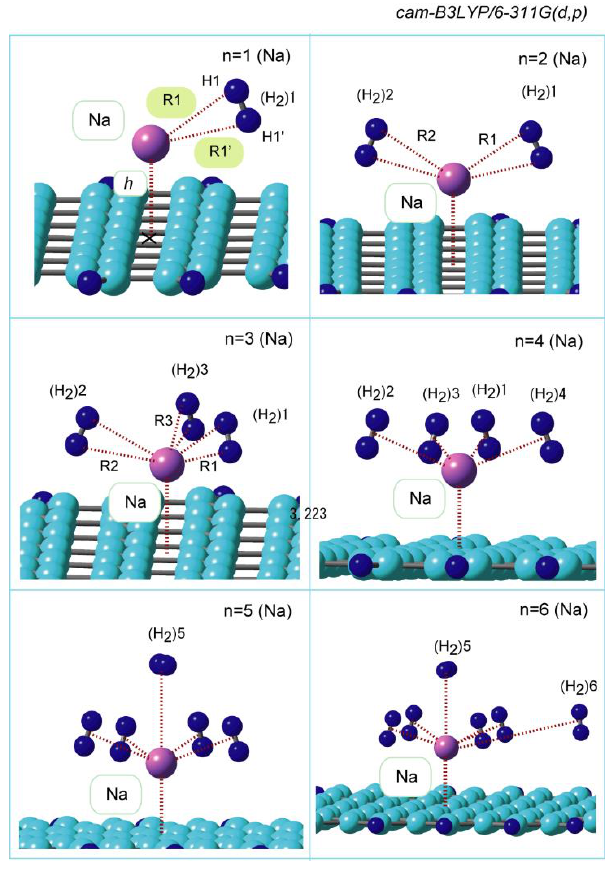
Figure 2. CAM-B3LYP/6-311G(d,p)-optimized structures of GR-Na (atom)-(H 2 ) n ( n = 1 – 6). The structures of H 2 bound to GR-Na + (ion) were optimized in the same manner and are shown in Figure S3. Similar binding structures were obtained for Na + , in which inner-shell H 2 molecules bind to GR-Na + in side-on orientations.